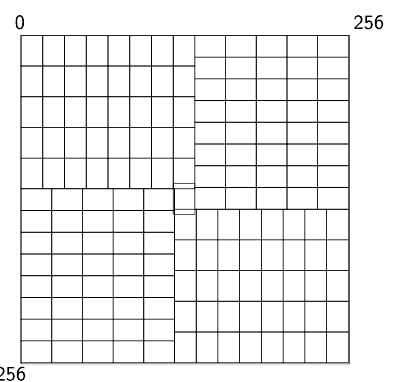
Figure 5: The 257-bit signed multiplier, based on the 256-bit multiplier from [RMIT14].